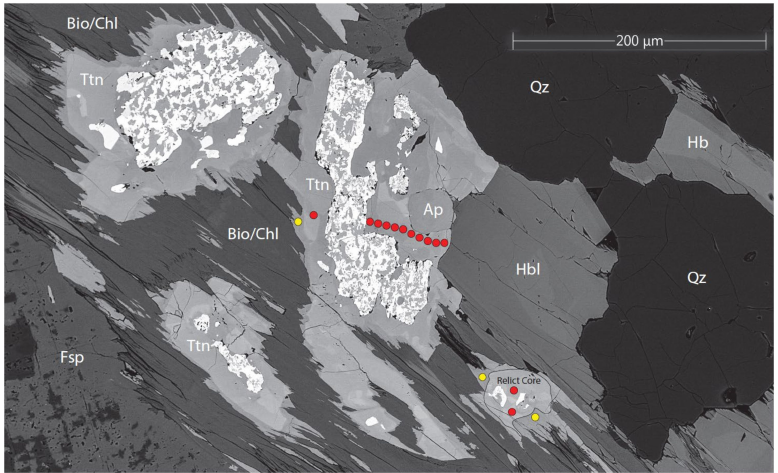
Figure 10. Backscattered electron (BSE) image of titanite grains in the Rocky Range pluton, Utah. Electron microprobe spots are shown in the partially resorbed, irregular shaped cores (red spots) and in the darker hydrothermal overgrowth rims (yellow spots). Titanite grew around Fe-Ti oxides that are now exsolved into Fe-oxides (bright) and rutile (gray). The hydrothermal overgrowths on titanite grains have feathered out into the surrounding chloritized biotite along cleavage planes. Minerals in the photo include titanite (Ttn), apatite (Ap), biotite/chlorite (Bio/Chl), quartz (Qz), hornblende (Hb), and feldspar